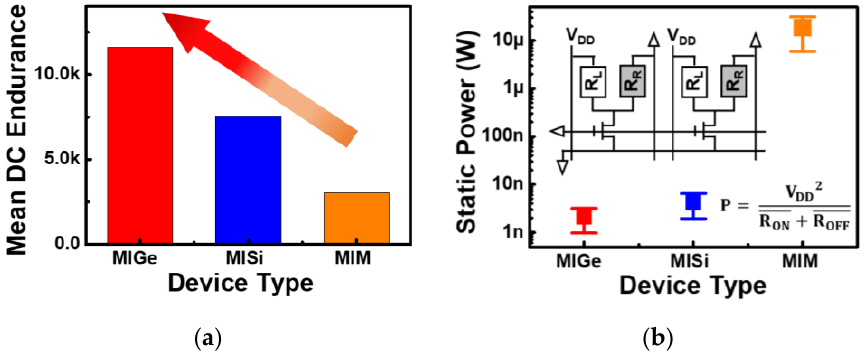
Figure 7. MIGe, MISi and MIM devices’ ( a ) mean DC endurance and ( b ) static power (V dd = 1.8 V) of FPGA’s pull-up/pull-down resistors.